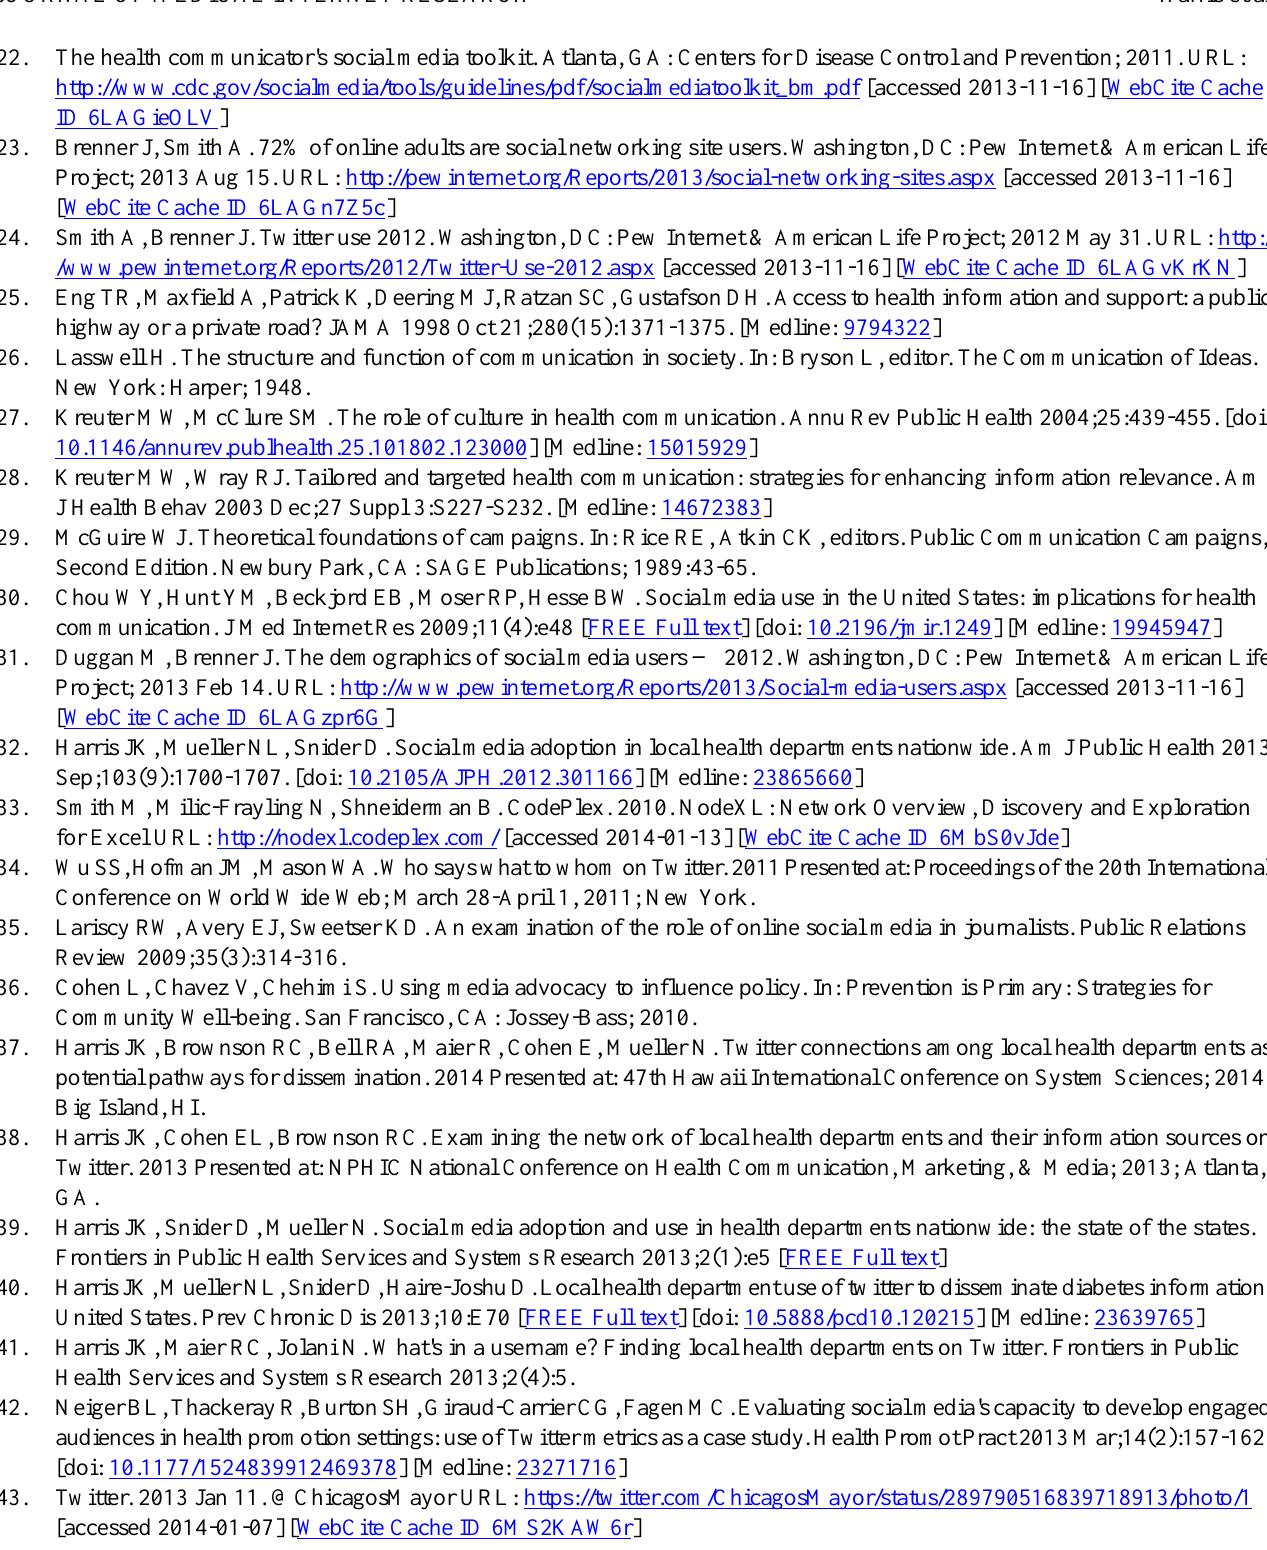
Abbreviations NACCHO: National Association of County and City Health